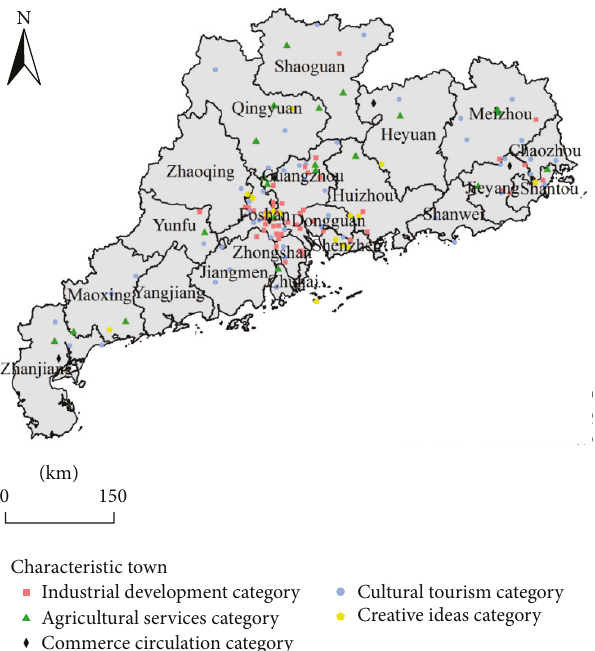
Figure 1: Spatial distribution of characteristic towns in Guangdong